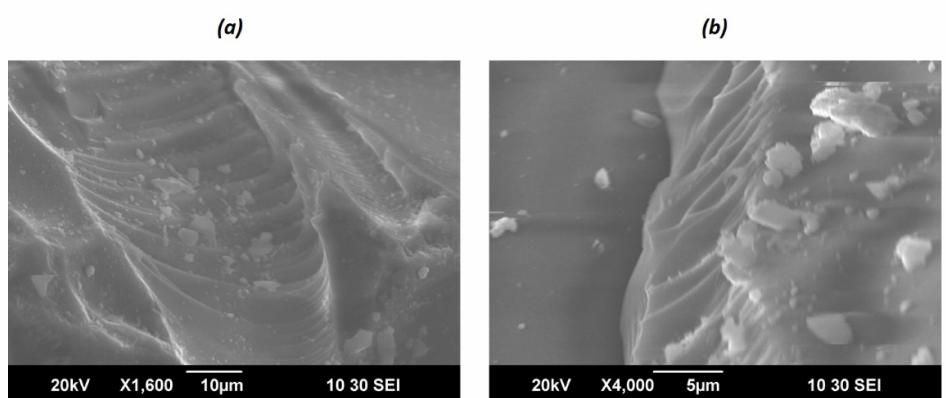
Figure 1. SEM image of TiO 2 (7%)-SiO 2 samples. Metric scale ( a ) 10 µ m and ( b ) 5 µ m in 1 cm of the image. The infrared spectrum of the SiO 2 xerogel (Figure 2a) had an intense complex-shaped absorption band, with the maxima at 1155 and 1062 cm − 1 , and an absorption band with a maximum at 798 cm − 1 corresponding to stretching vibrations of Si–O–Si bonds.